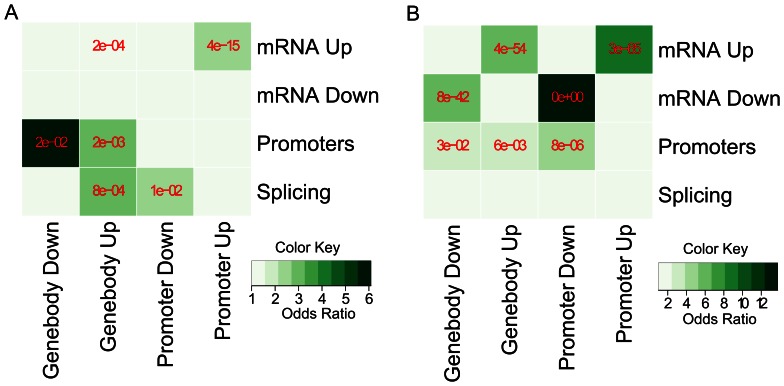
Heatmaps of correlation between chromatin modification differential sites and differential transcriptomic events on the ENCODE data.mRNA Up, mRNA Down: overall gene expression change. Promoters: alternative promoter usage. Splicing: alternative splicing. The darkness of the color indicates the odds ratio (i.e. observation/expectation) of enrichments. The p-values of enrichments are determined by Fisher’s exact test and are labeled in red color. (A) diffReps-specific: differential sites detected only by diffReps; (B) Overlap: differential sites detected by both diffReps and another method.